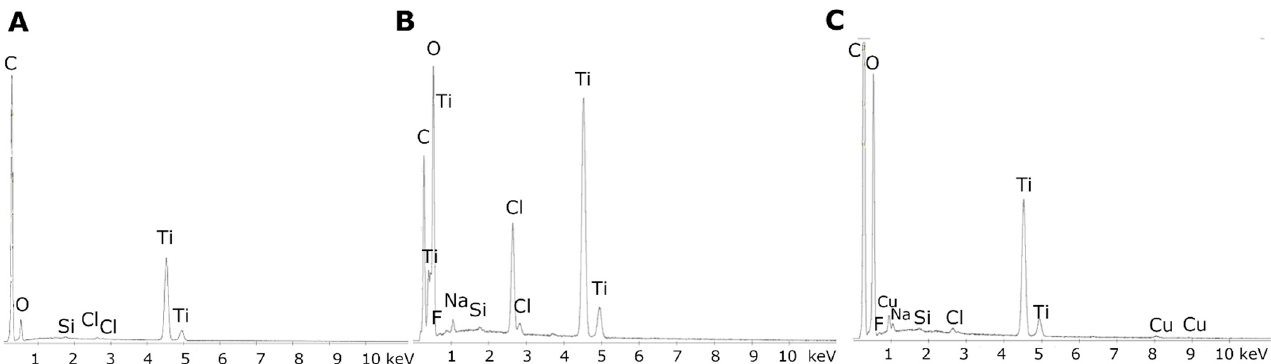
Figure 4. EDS spectra of the ( A ) MWCNTs reference, ( B ) MWCNTs/TiO 2 bi-layer coating, and ( C ) MWCNTs_Cu dispersion coating.